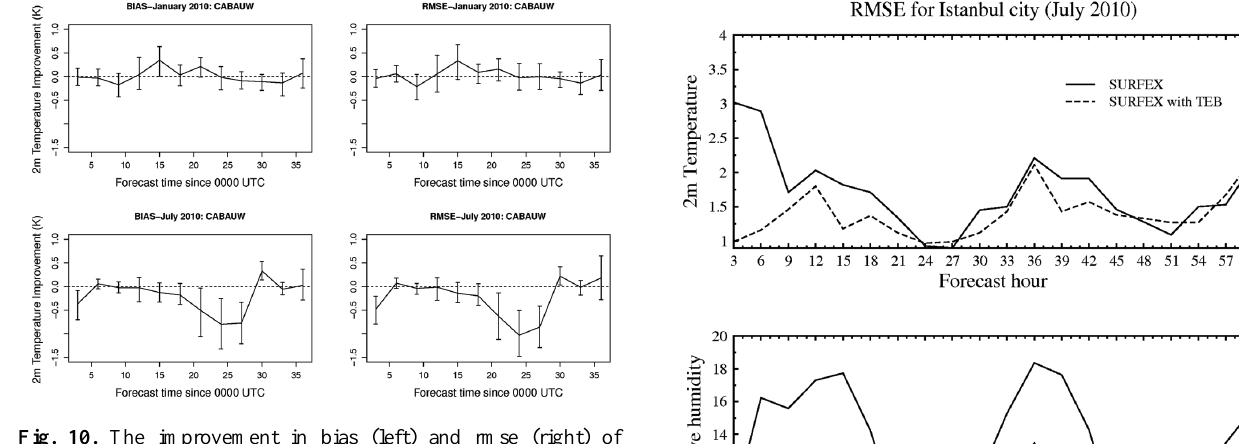
Fig. 10. The improvement in bias (left) and rmse (right) of the 2m temperature obtained when using SURFEX for Jan- uary (top) and July (bottom). The 95% confidence intervals for | bias |−| bias | and rmse − rmse OPER + SFX OPER OPER + SFX OPER were calculated with the bootstrap method.